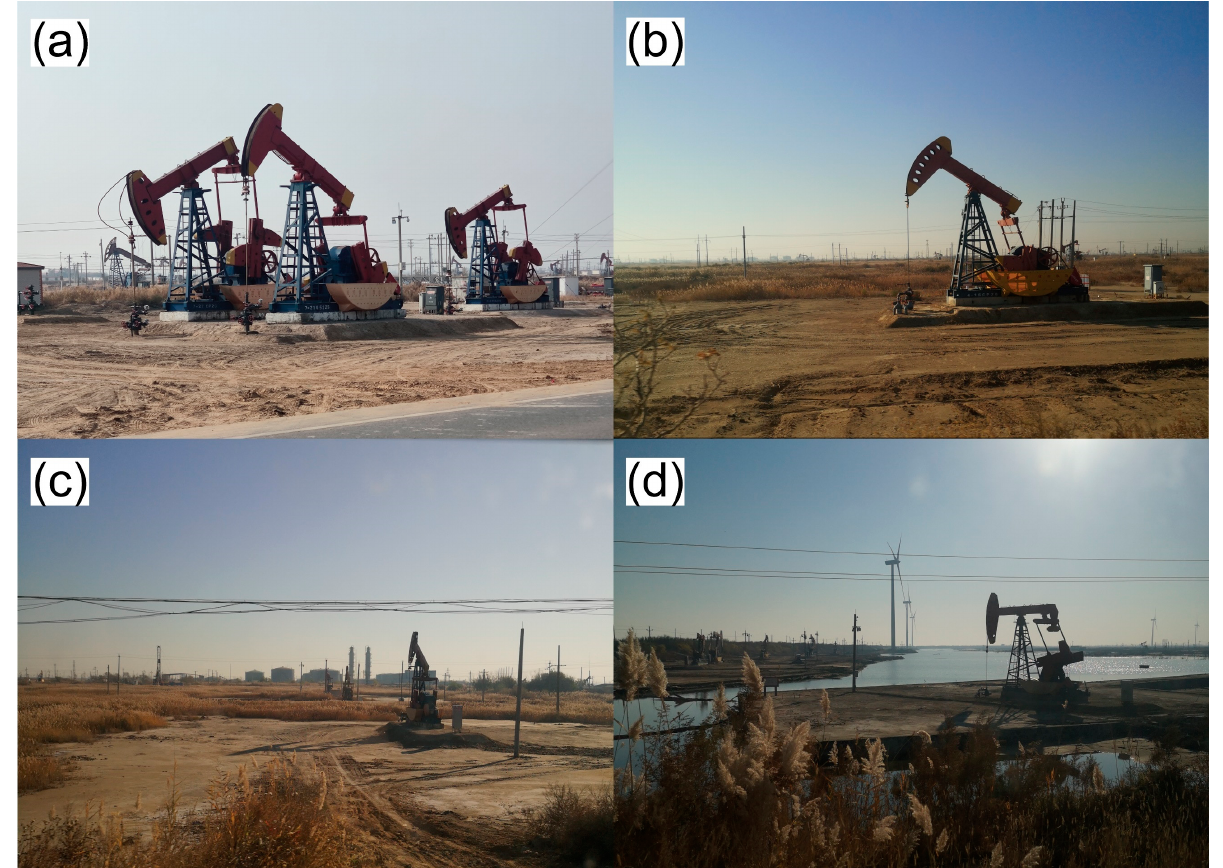
Figure 11. Photos of pumping units taken in industrial land of the YRD. ( a ) Pumping units in the industrial land; ( b ) Pumping units in the bare land; ( c ) Pumping units near the building; ( d ) Pumping units near the saltpan.